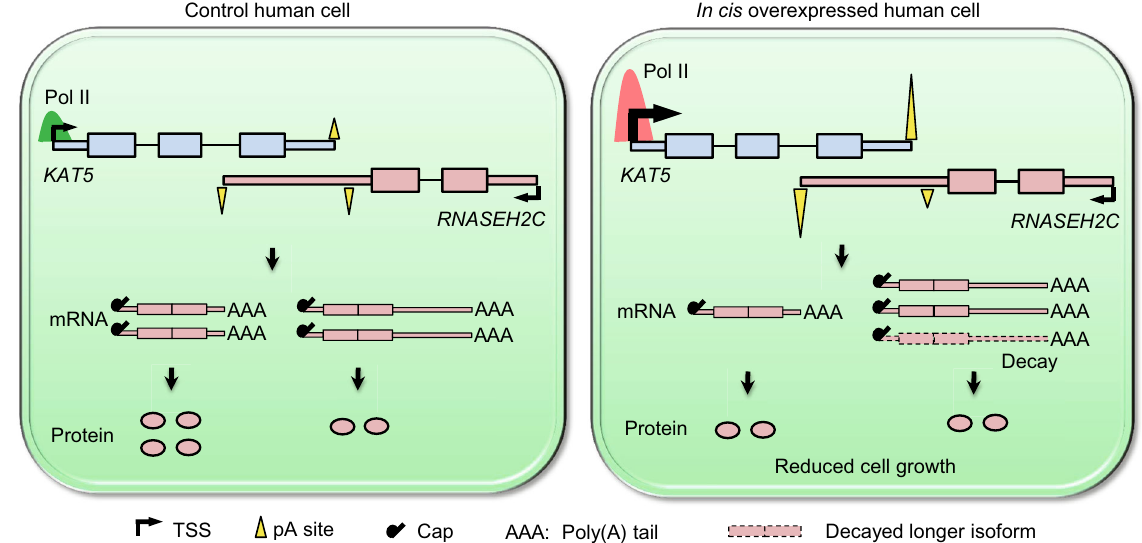
Figure 7. Working model for antisense transcription mediated regulation on sense gene via APA. RNASEH2C and KAT5 are tail-to-tail overlapping in human genome. Overexpression of KAT5 in cis caused the elevated occupancy of Pol II on KAT5 and extended to RNASHE2C gene body, leading to the preference of distal pA site in RNASHE2C . Higher distal pA site usage of RNASEH2C resulted in increased abundance of isoform with longer 3 ′ UTR, which generated less protein than the shorter one. In addition, transcripts with longer 3 ′ UTR had higher degradation rate, further aggravated the reduction in RNASEH2C protein production. Thus in cis elevated antisense transcription down-regulated sense gene ’ s protein level, leading to reduced cell growth